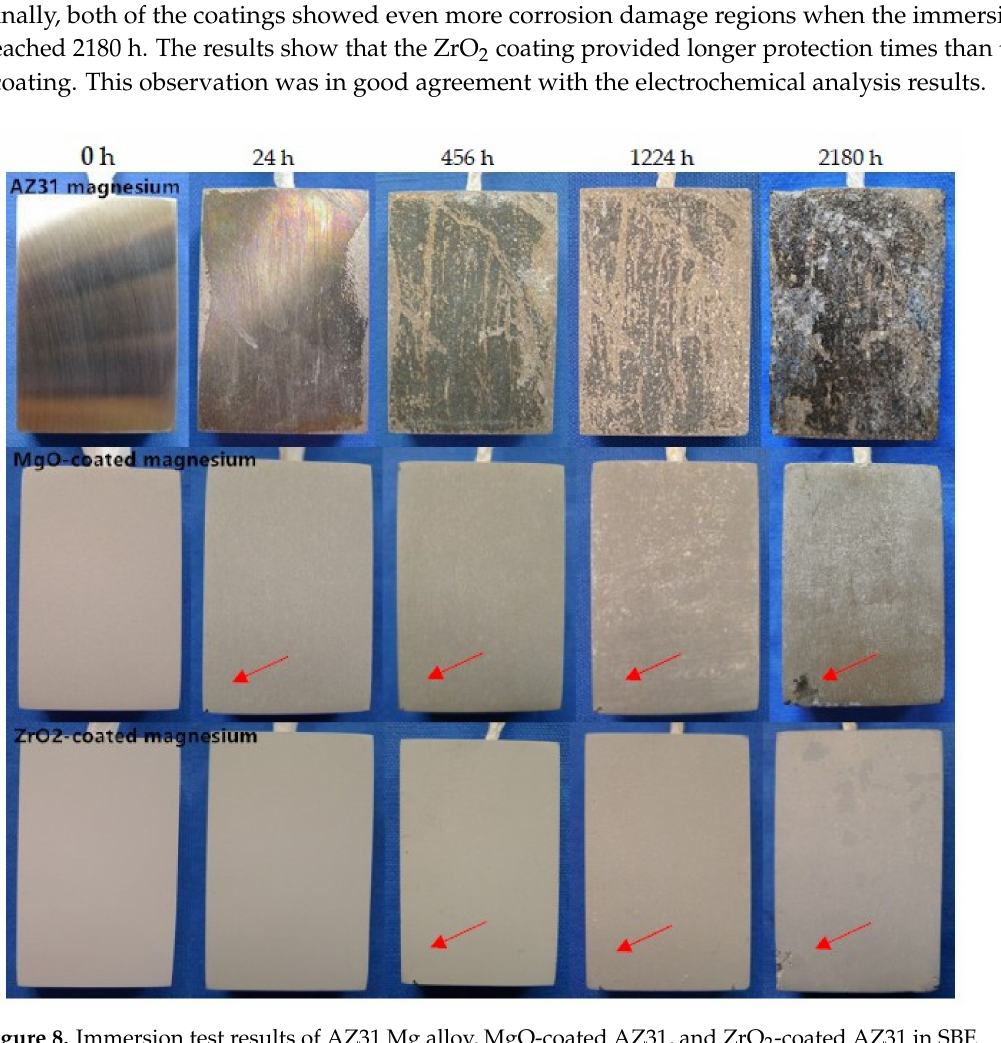
Figure 8. Immersion test results of AZ31 Mg alloy, MgO-coated AZ31, and ZrO 2 -coated AZ31 in